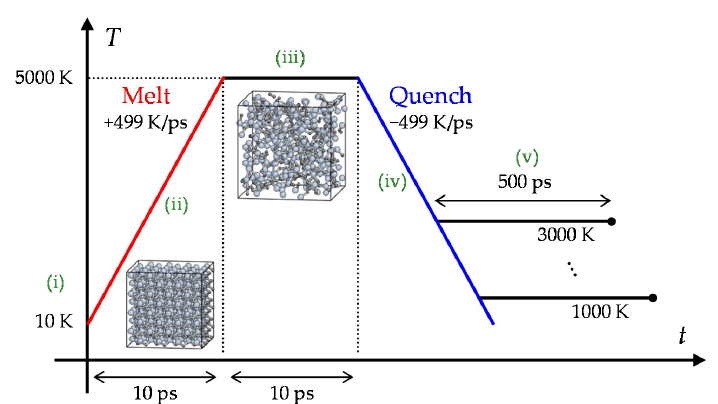
Figure 6. Procedure of preparation for amorphous structures.